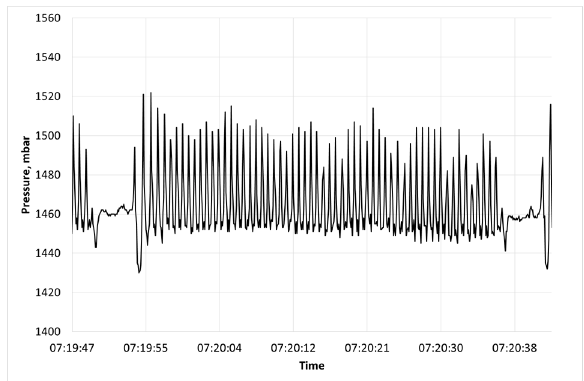
Figure 4. Measurement of jaw motion during rumination using pressure halter [18].